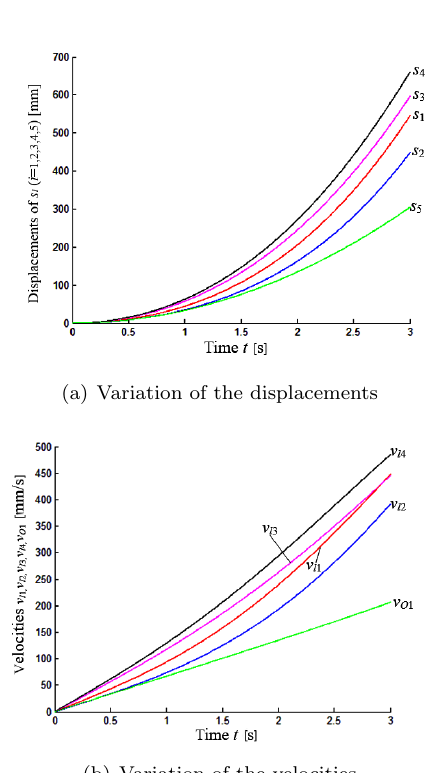
Figure 8: The kinematics and dynamics results of the GHMT obtained from ADAMS